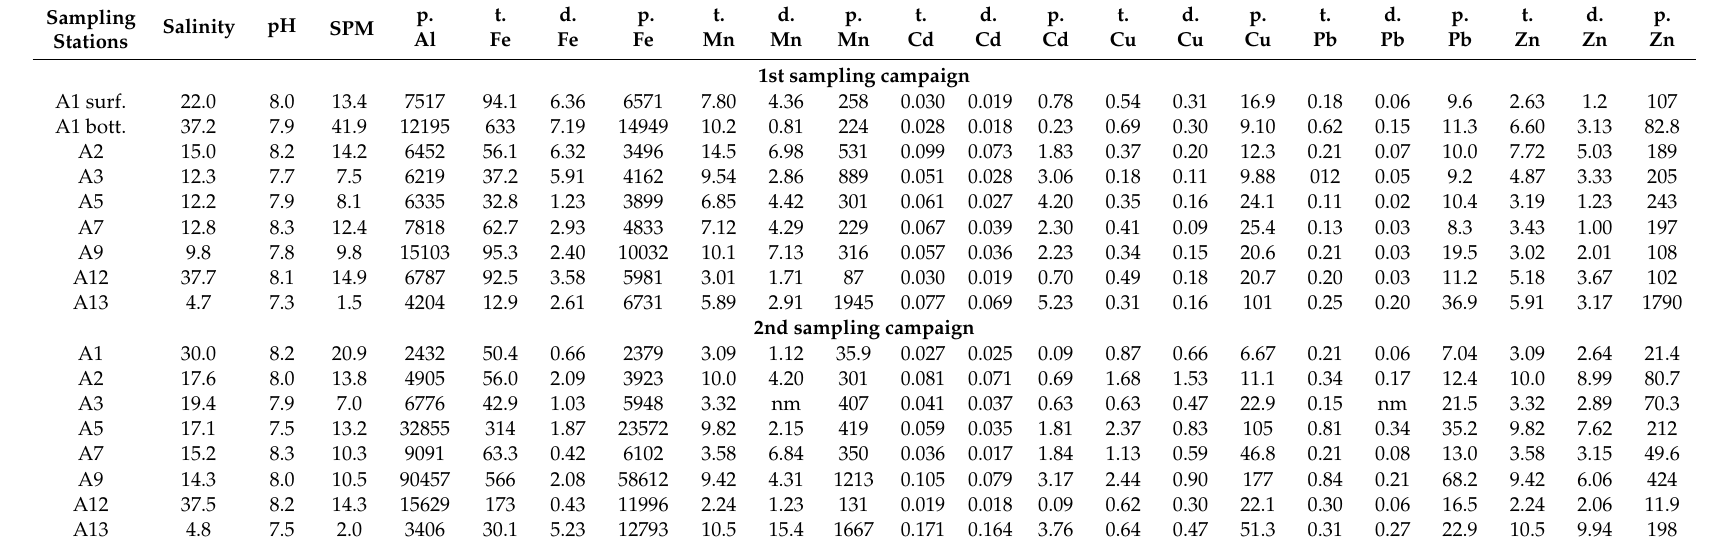
Table A1. Detailed results of salinity, pH, Suspended Particulate Matter (SPM in mg · L − 1 ) and dissolved (d. in µ g · L − 1 ), total (dissolved and particulate, t., in µ g · L − 1 ) and particulate (p. in mg · kg − 1 ) metal concentrations of the 1 st and 2 nd sampling